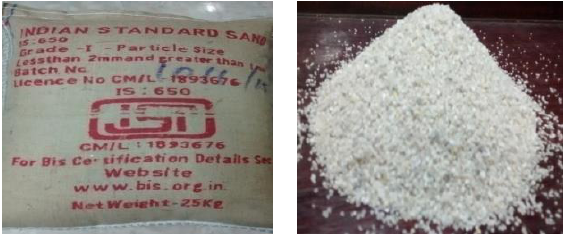
Figure 3. Grade-I : Less than 2 mm greater than 1 mm.